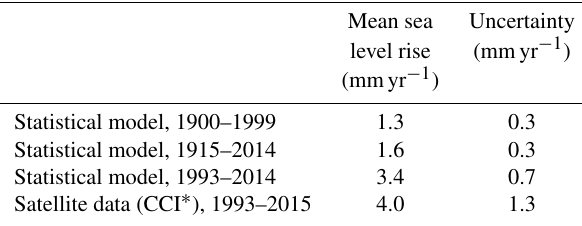
Table 1. Rates of mean sea level rise for the Baltic Sea and esti- mated uncertainty (1 standard deviation range) based on Madsen et al.